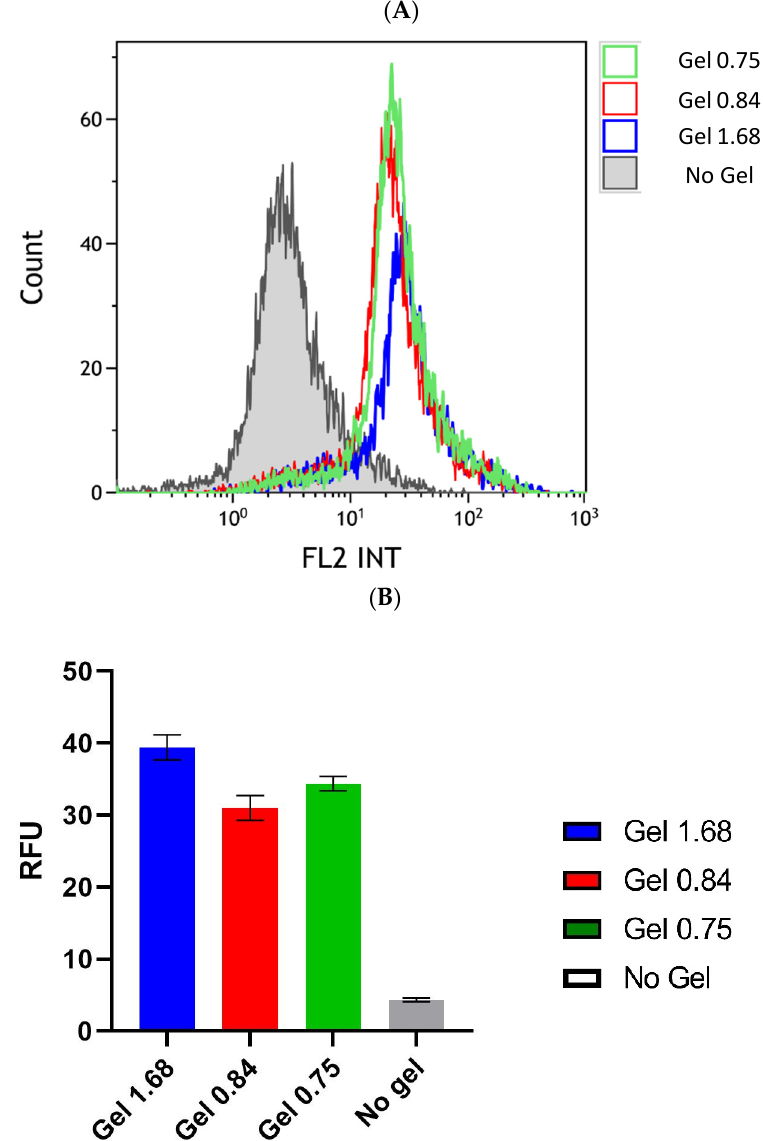
Figure 4. Cellular uptake of Dox released from ELP hydrogels. ( A ) The U-87 MG uptake of doxorubicin from hydrogels was measured by flow cytometry. The x -axis of the histogram represents fluorescence detected within the range emitted by doxorubicin; the y -axis represents a relative number of events/cells counted. The control peak (gray) represents cell autofluorescence. ( B ) Comparison of mean fluorescence values for three uptake experiments (including the one shown in ( A )); bars are SEM.